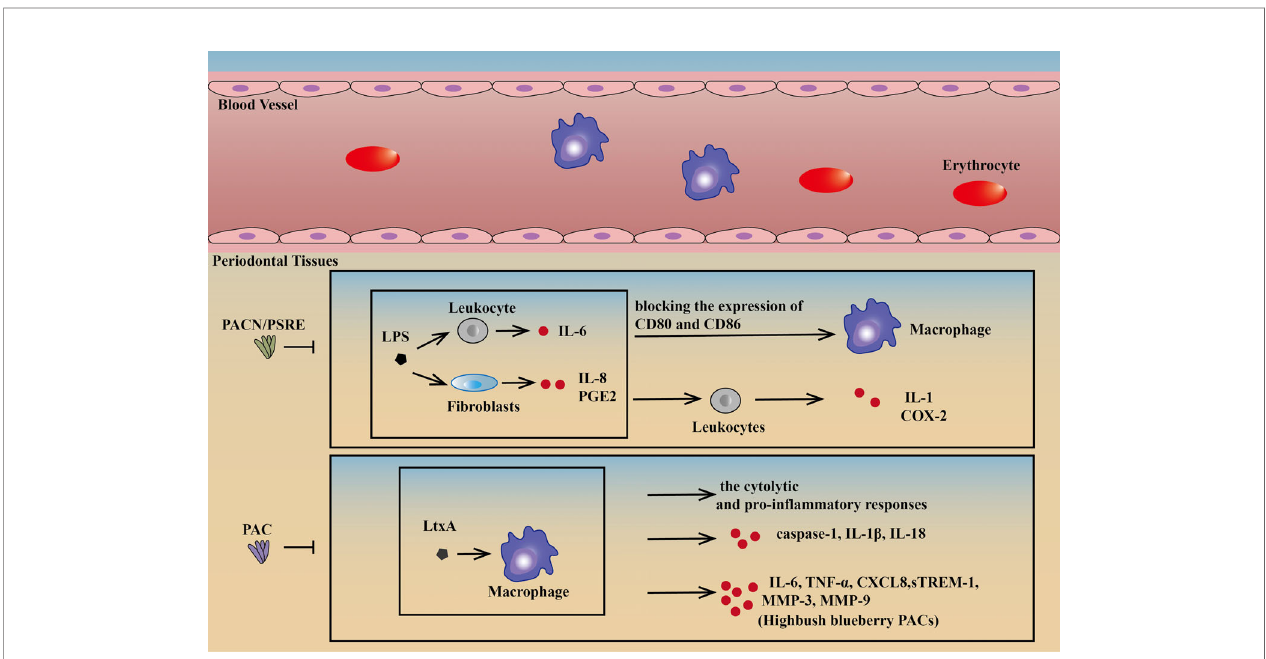
FIGURE 3 | Drugs targeting macrophages. PSRE and PACN can decrease IL-8 and PGE2 by lipopolysaccharide-induced fi broblasts and IL-6 by leukocytes, blocking the expression of CD80 and CD86 on the surface of macrophages and IL-1 and COX-2 in leukocytes (64). PAC can protect macrophages against the cytotoxic effect of puri fi ed LtxA, reducing caspase-1 activation in LtxA-treated macrophages, consequently decreasing the release of IL-1 b and IL-18. PACs can also neutralize the cytolytic and pro-in fl ammatory responses of human macrophages treated with LtxA. In addition, highbush blueberry PACs can also inhibit the secretion of IL-6, CXCL8, TNF- a , MMP-3, MMP-9, and sTREM-1in a dose-dependent manner (57, 65). PSRE, Pelargonium sidoides DC root extract; PACN, Proanthocyanidins; PAC,